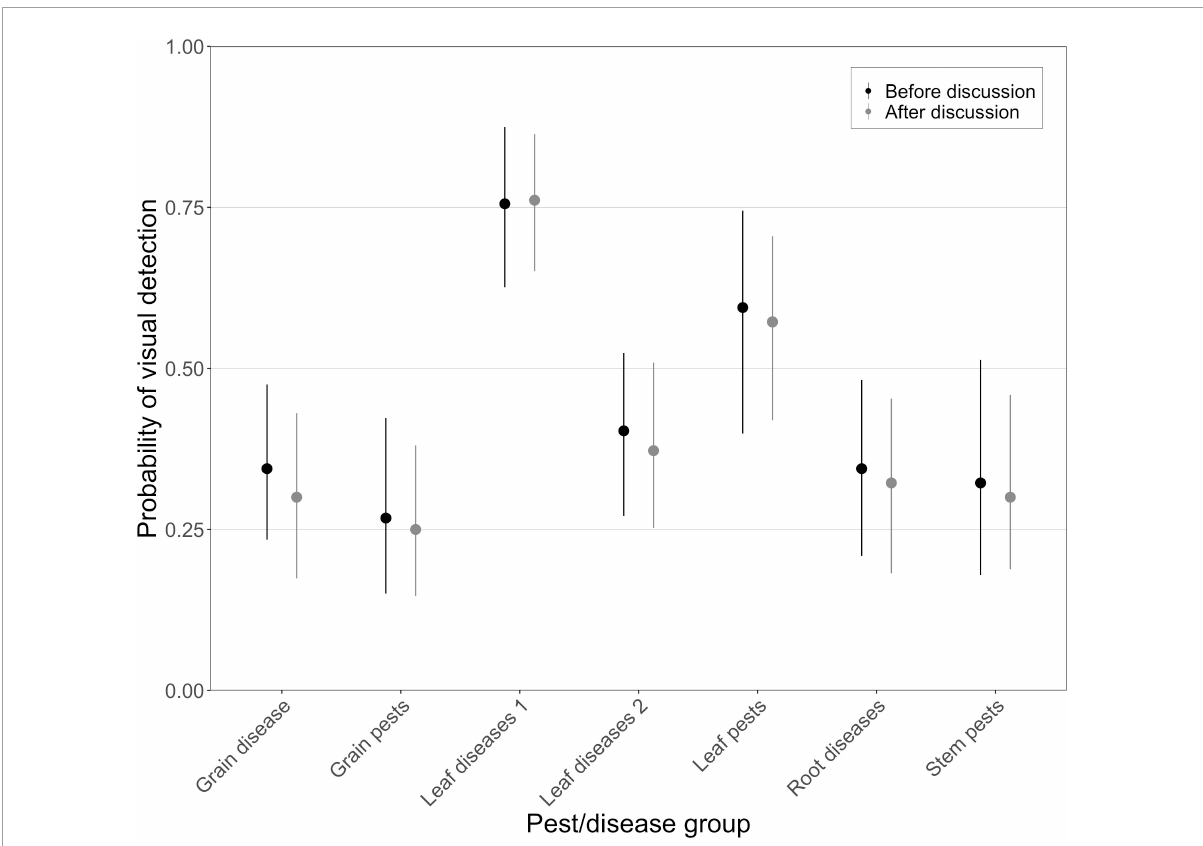
FIGURE5 Aggregated 80% intervals for the probability of detection of exotic pests and diseases during visual inspection. Pests and diseases are divided into seven groups. Best estimates (means), with 80% upper and lower credible intervals, are shown for the first and second round of expert elicitation. Black circles represent best estimates before discussion (initial estimates) and gray circles represent best estimates after discussion (final